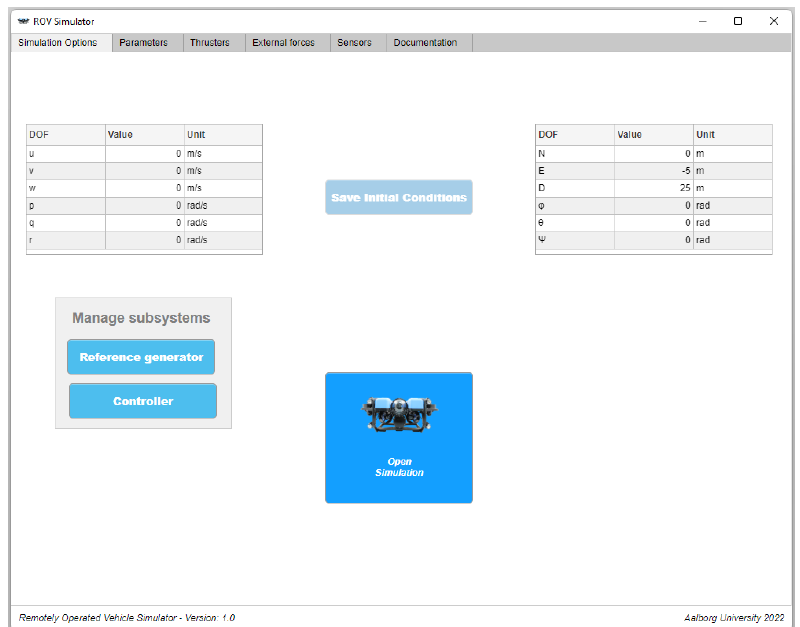
Figure A2. Overview of the simulation options pane within the ROV simulator app.